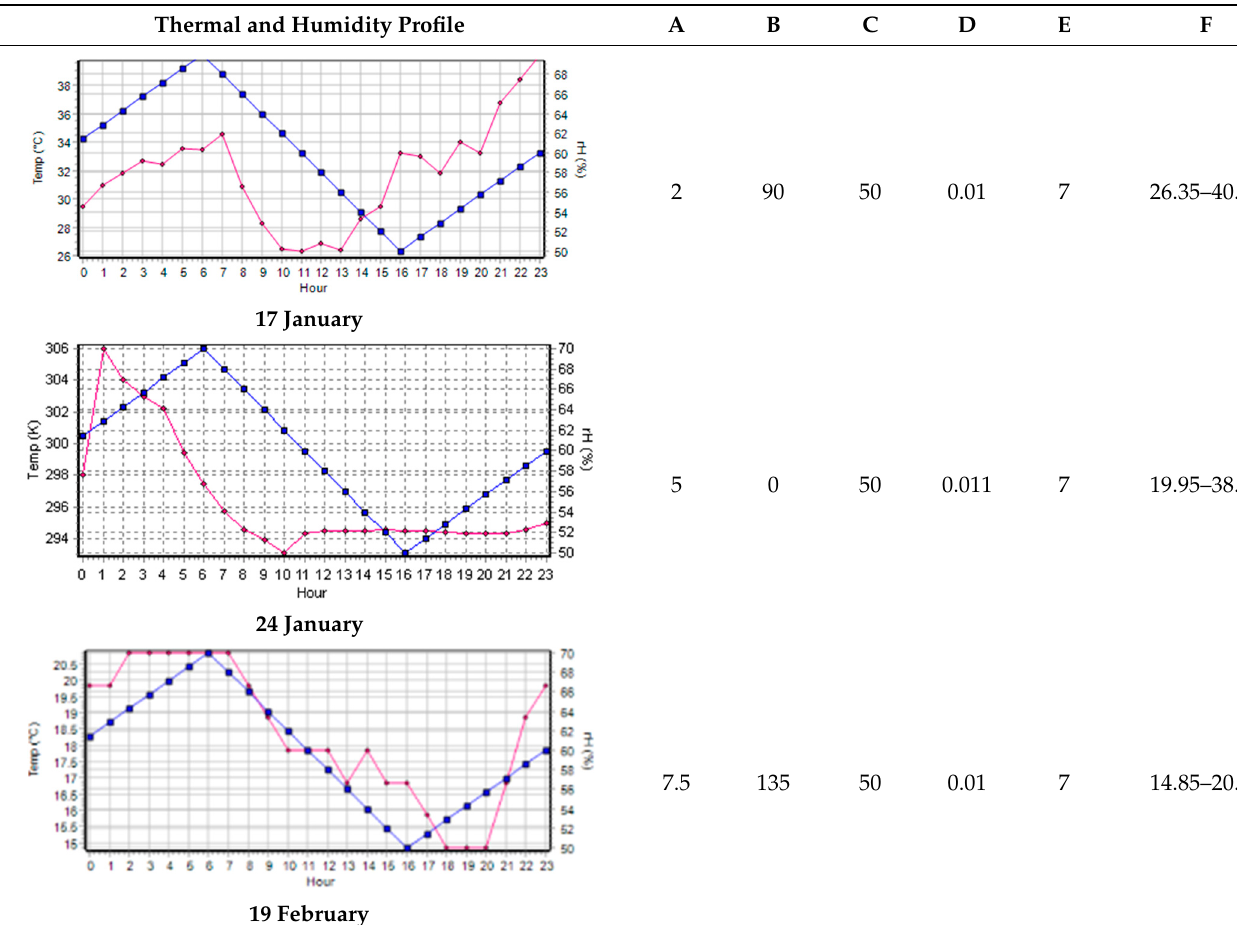
Table 5. Meteorological condition of three summer day (A = Wind speed measured in 10 m height (m/s), B = Wind direction(0 = North and 180 = South, C = Relative humidity in 2 m (%), D = Roughness length at measured site, E = Specific humidity at model top and F = Minumum/maximum temperature (°C)). Thermal and Humidity Profile